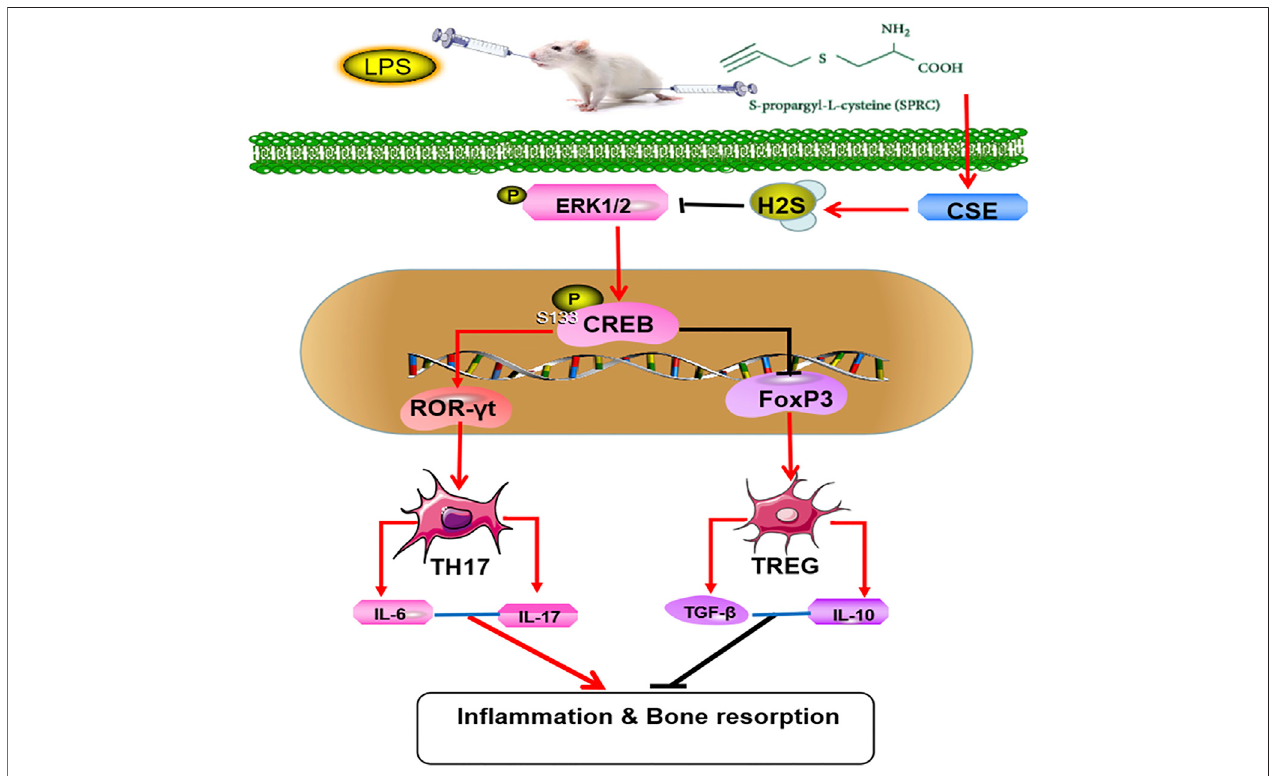
FIGURE 7 | Mechanisms of SPRC in alleviating periodontitis,SPRC prevent the rat chronic periodontitis through synthesis of endogenous H2S by CSE catalysis. Endogenous H2S inhibited the activation and proliferation of Th17 cells and promoted the activation and proliferation of Treg cells through inhibiting ERK1/2 and CREB phosphorylation. (Red lines indicate promotion, black lines indicate